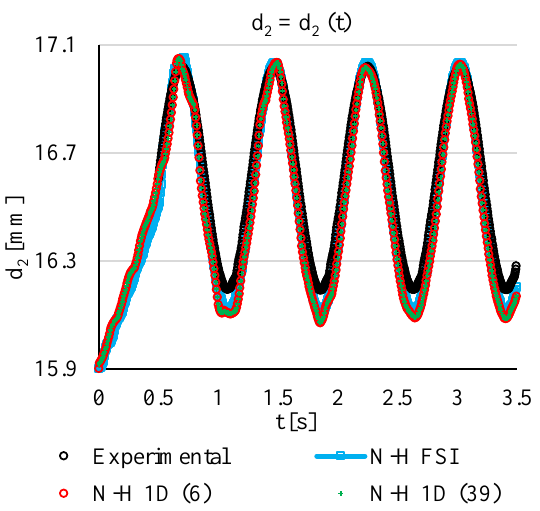
Fig. 18. Diameters d 2 of thick-walled tube.